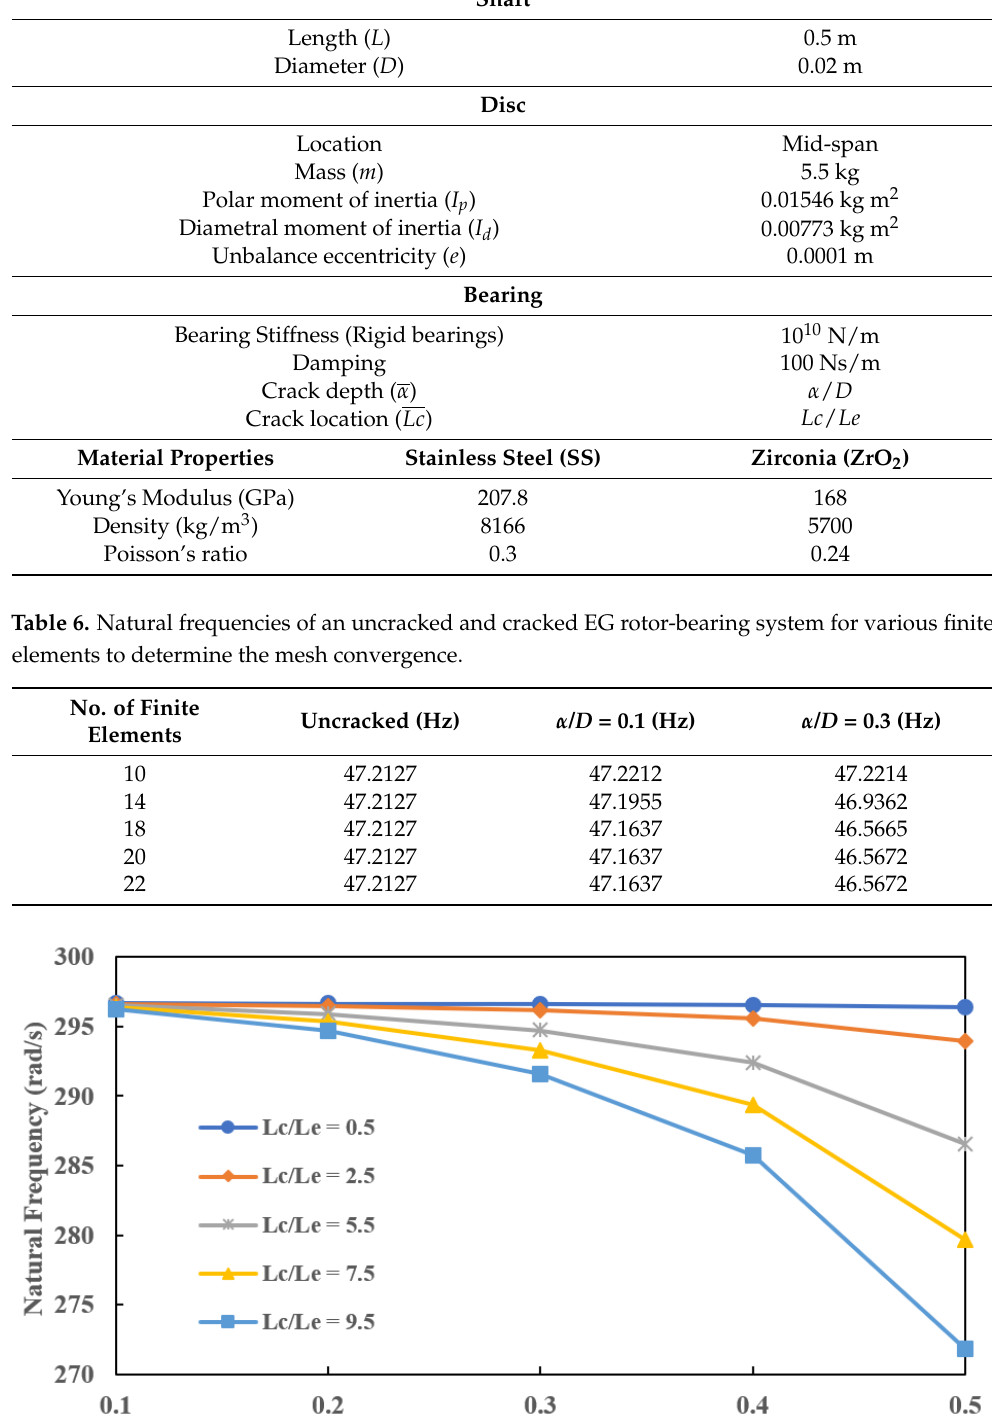
Table 6. Natural frequencies of an uncracked and cracked EG rotor-bearing system for various finite elements to determine the mesh convergence.